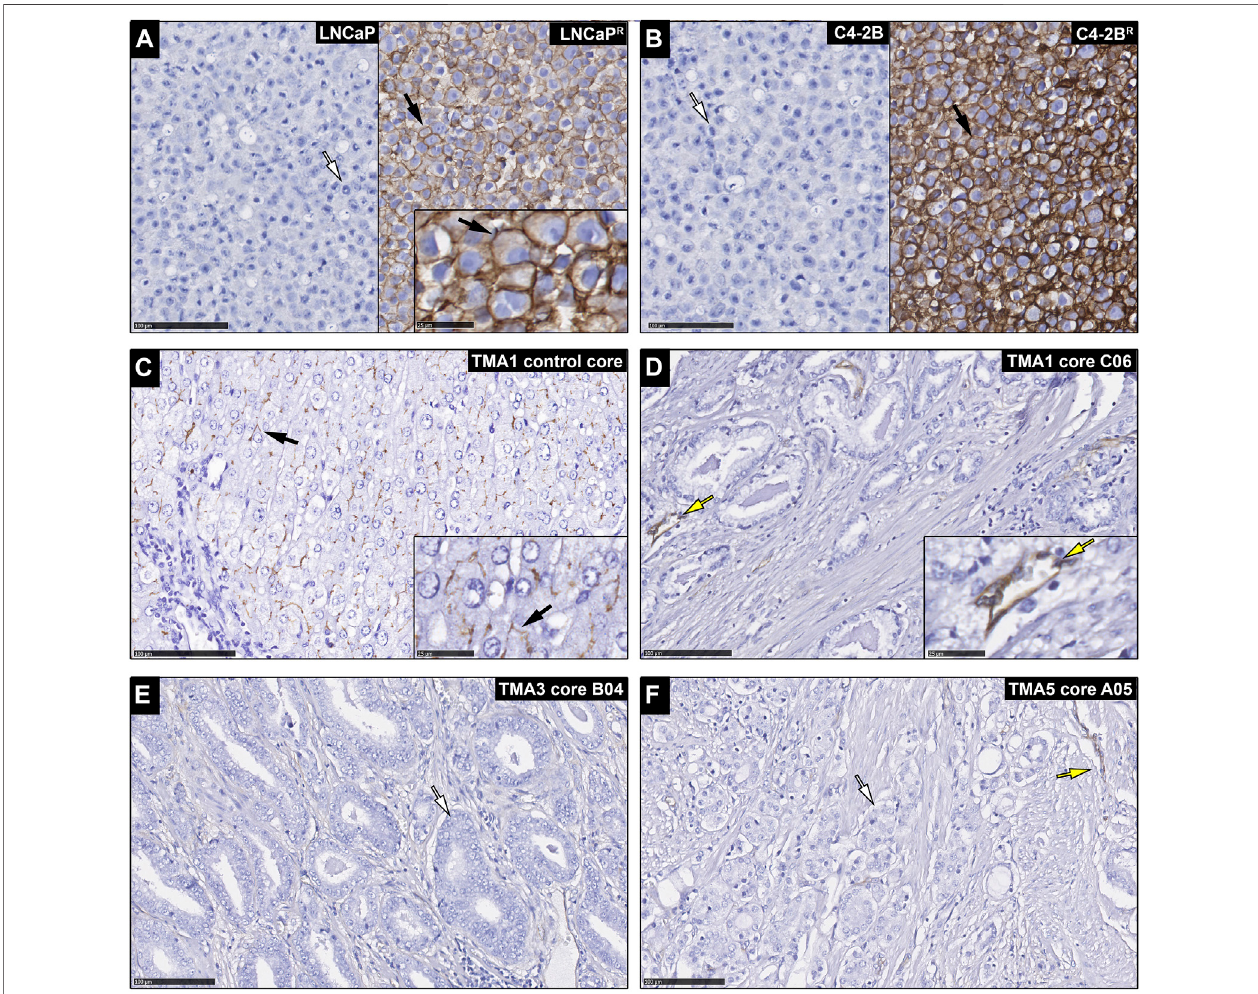
FIGURE1| ExpressionofABCB1inchemo-naïveprostatecancerpatients.ImmunohistochemicalanalysisofABCB1expressionin (A) LNCaPcells(leftpanel)with white arrow indicating a cell with no immunostaining, and LNCaP R cells (right panel) with black arrow indicating a cell with ABCB1 immunostaining (inset is a higher magni fi cationimagewithblackarrowshowingcellmembranestaining). (B) C4-2Bcells(leftpanel)withwhitearrowindicatingacellwithnoimmunostaining,andC4-2B R cells (right panel) with black arrow indicating a cell with ABCB1 immunostaining. (C) Normal liver tissue with black arrow indicating membrane immunostaning (control core; inset is a higher magni fi cation image with black arrow showing cell membrane staining). (D – F) prostate carcinomas with glandular cells showing no immunoreactivity (white arrows) and staining observed only in blood vessels (yellow arrows). Scale bars, 100 and 25 µm in inset images.